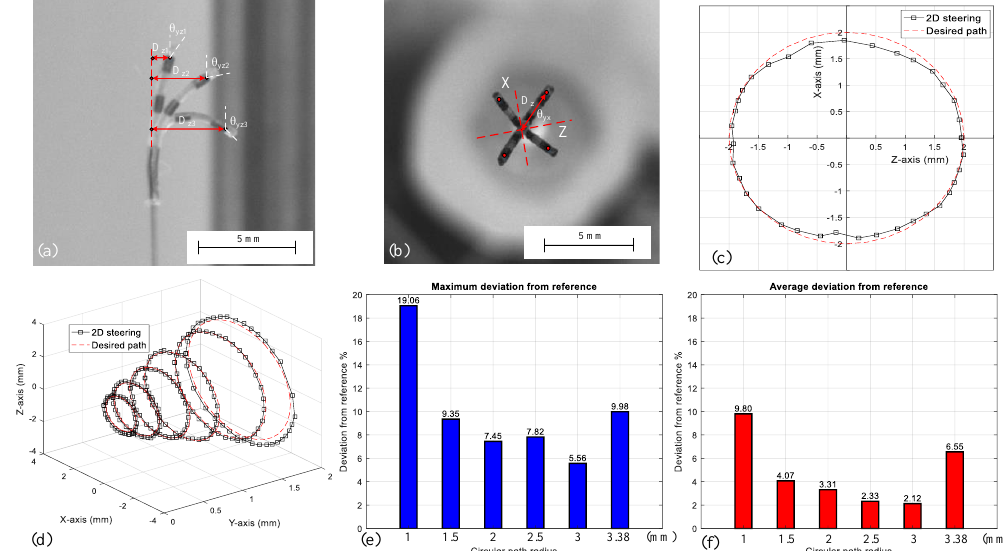
Figure 6. ( a ) 1D steering of a microrobot with different deformation radii ( D z ); ( b ) 2D steering of a flexible microrobot with different deformation directions of the end-effector ( θ yx ); ( c , d ) the compression between the desired path and experimental results ( θ r is 33 ◦ and θ y varied between 0 ◦ and 360 ◦ ); ( e ) 2D steering for different deformation radii D z , for the circles (from 1 to 3.38 mm radius) θ r is 15 ◦ , 23 ◦ , 33 ◦ , 46 ◦ , 65 ◦ , 105 ◦ , respectively, and θ y is varied between 0 ◦ to 360 ◦ , ( e ) maximum deviation between the experimental and the desired position ( f ) average deviation between the experimental and the desired